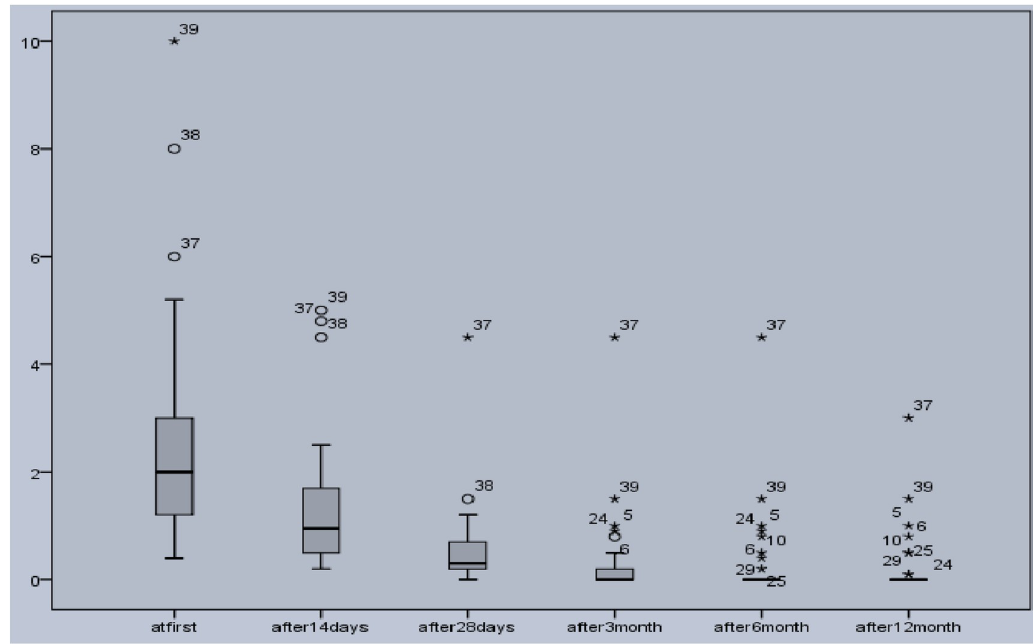
Fig 1. Box-plot graph of induration sizes in 42 cutaneous leishmaniasis lesions treated with oral miltefosine. X axis represents time of evaluation and Y axis represents lesion induration size (Cm).